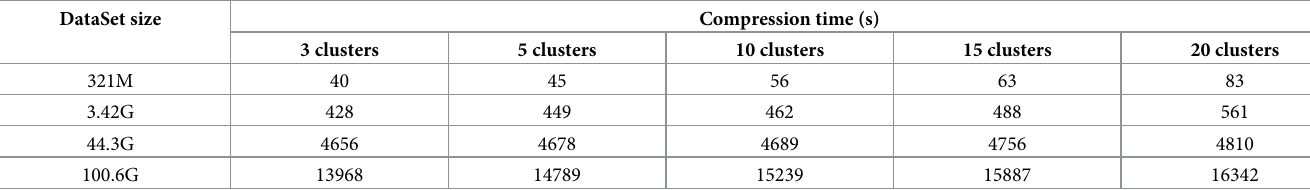
Table 3. Time needed to compress by TRCMGene.